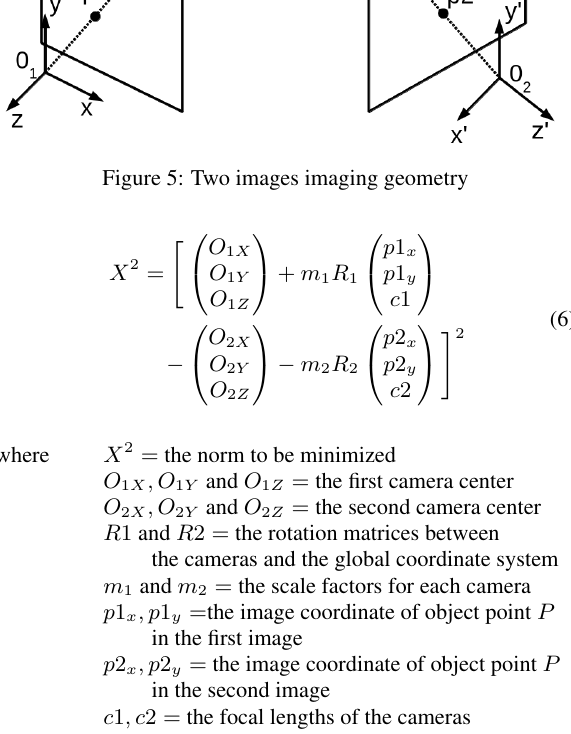
das RAW. Figure 6 schematizes the DTM creation process. The object points are converted from 3D body-centric coordinates to map coordinates and a template DTM is filled with the values from coinciding points by applying different interpolation meth- ods.